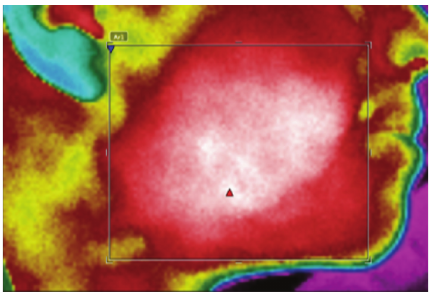
Figure 18: Temperature measurement of the face with increased temperature.